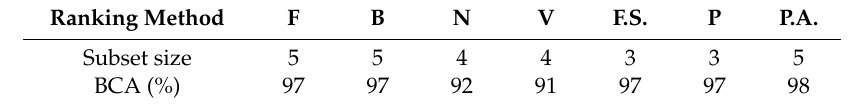
Table 9. Ranking methods performance comparison on the Cancer dataset using Logistic regression.